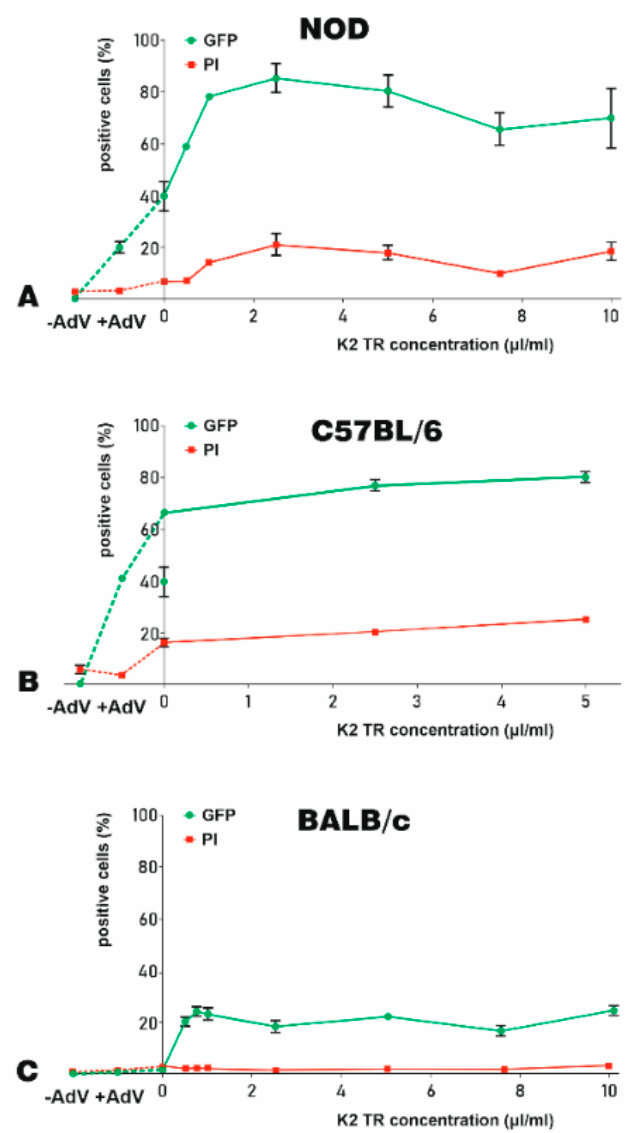
Figure 3. K2 Transfection Reagent K2TR optimization for the adenoviral transduction of murine MSC. The efficacy of K2TR to increase the yield of the adenoviral transduction of MSC derived from NOD ( A ), C57BL/6 ( B ), and BALB/c ( C ) mice were determined as % of GFP-positive cells (green lines). The cell death was determined by PI incorporation and expressed as % of PI-positive cells (red lines). On the left side of each graph, the GFP-positive cells and the cell death for the untransduced cells ( − AdV) and for the cells transduced with 250 TU/cell adenovirus alone (+AdV) were illustrated, linked by a dotted line. Adenoviral particles were complexed with various K2TR doses. MSC were incubated with 10 µ L/mL K2 Multiplier (K2M) and then the complexes of adenovirus–K2TR were added to the cells. The percentage of GFP-positive cells (green lines) induced by transduction and the percentage of PI-positive cells (red lines) were determined 48 h after transduction, by flow cytometry.